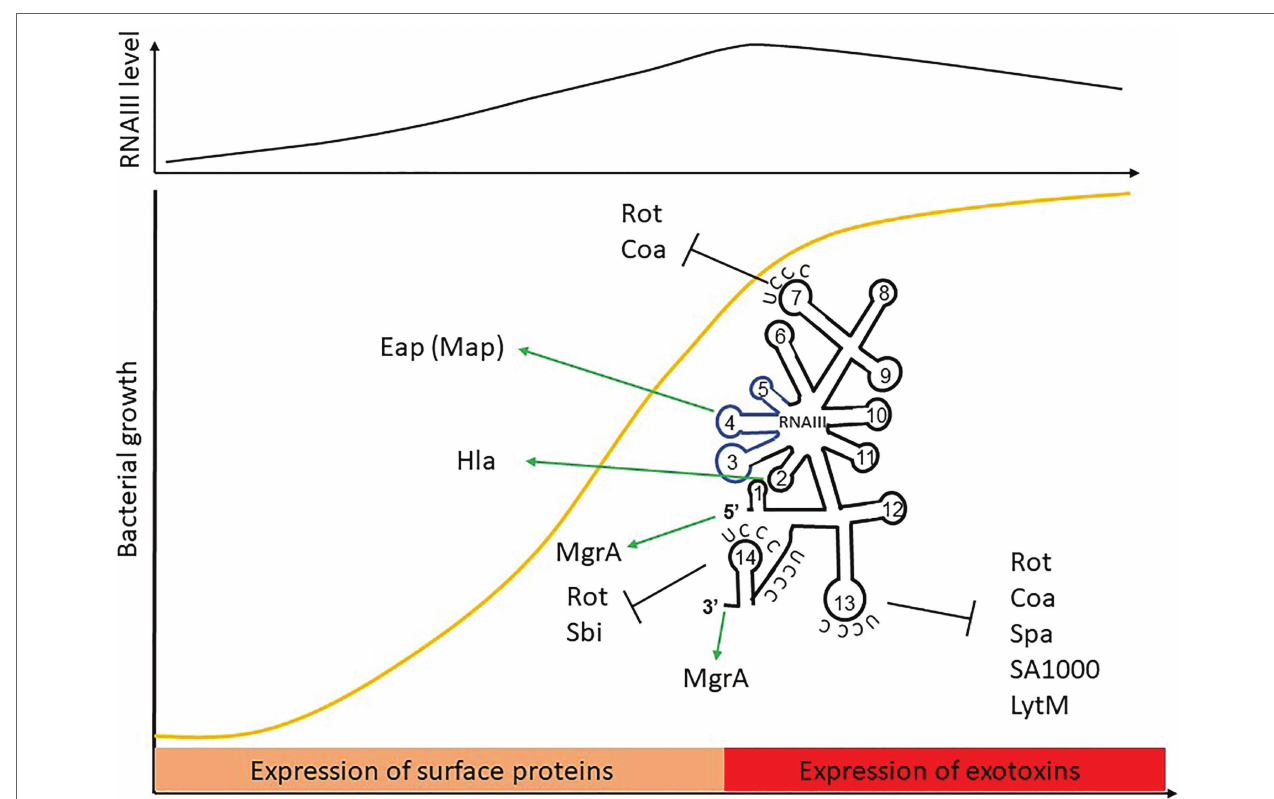
FIGURE 6 | The RNAIII paradigm: activation and repression of gene expression is carried out by a dual-function sRNA encoding δ -hemolysin. The hld coding sequence is